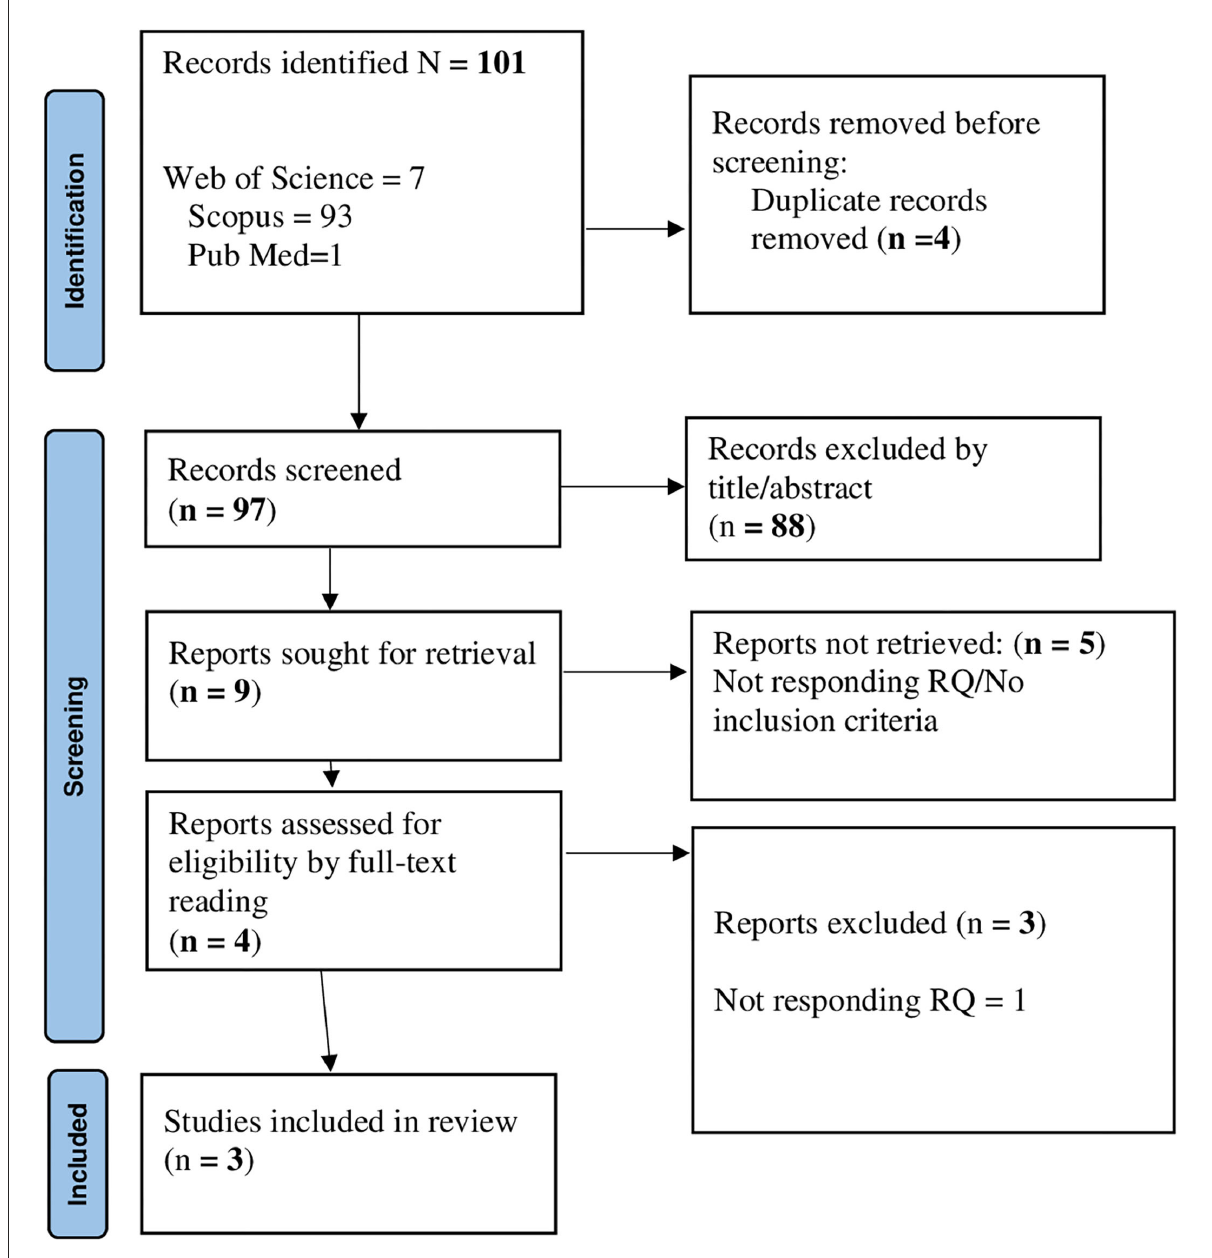
FIGURE2 PRISMA flowchart for the factors are associated with HE students’ academic